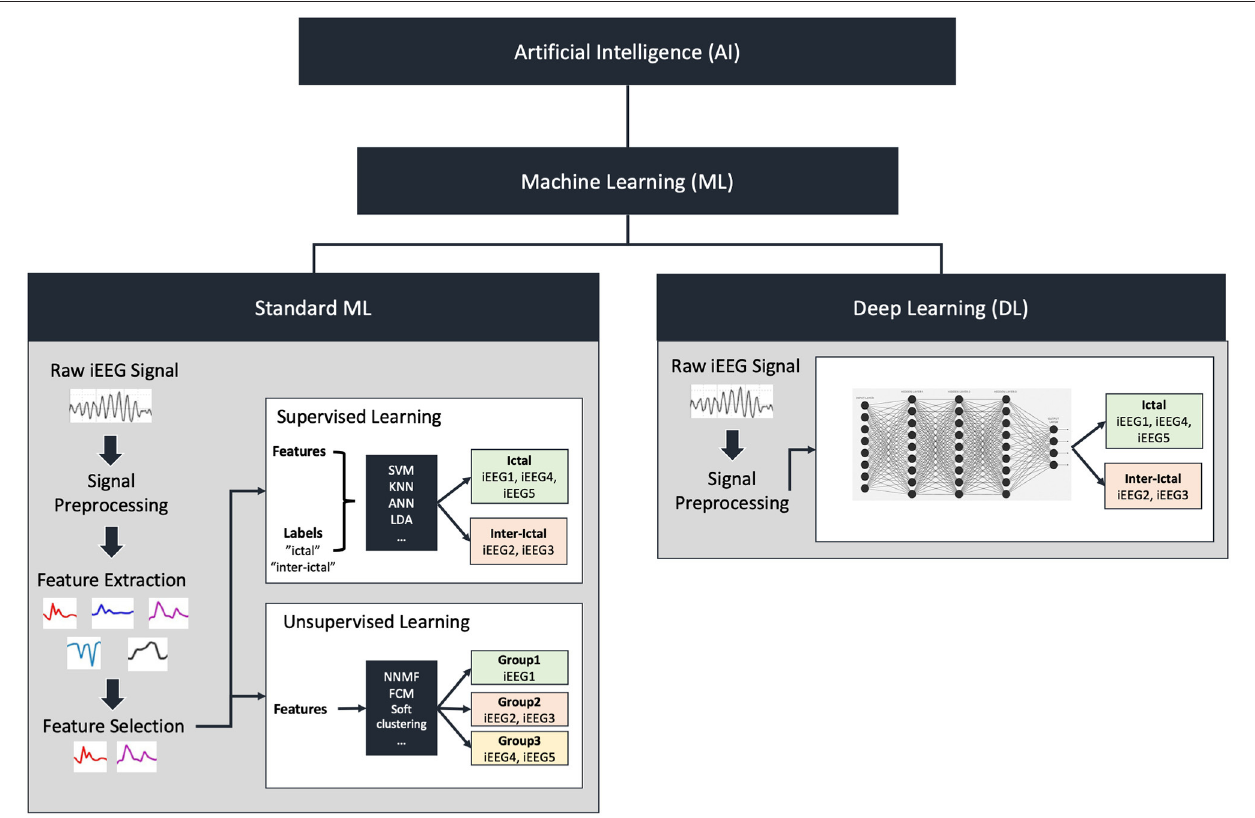
FIGURE 1 | Overview of artificial intelligence and machine learning. Artificial intelligence includes machine learning (ML) which can be divided into standard machine learning or deep learning. In standard ML, raw iEEG signal is preprocessed followed by feature extraction and selection. Feature extraction involves breaking down the raw signal into individual quantifiable components such as power at various frequencies. Feature selection on the other hand involves selecting a subset of these components to be used to train a model. These features can either be fed to a supervised learning algorithm in addition to group labels, or an unsupervised learning algorithm that does not contain labels. Examples of supervised algorithms include support vector machines (SVM), K-nearest neighbors (KNN), artificial neural networks (ANN) or linear discriminant analysis (LDA). These classify the features into the group labels provided as inputs. Examples of unsupervised algorithms include non-negative matrix factorization (NNMF), fuzzy-c-means (FCM), and soft clustering. These will classify the features into groups based on similarity. Deep learning does not require feature extraction and selection. The processed or unprocessed signal can be fed directly into the deep learning model to classify the